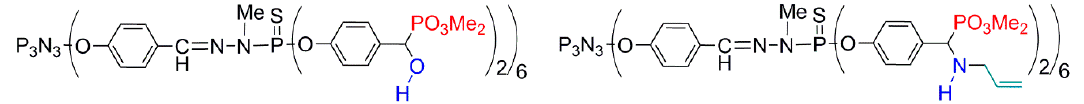
Figure 18. Results of the addition of dimethylphosphonate on terminal aldehydes ( left ) or imines ( right